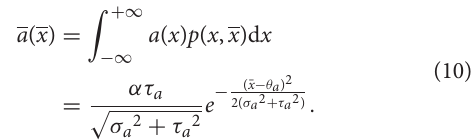
FIGURE 4 | low abundances is taken into account. A shorter handling time ( h prevents trait evolution. When selection is moderately strong ( τ a exceeds the levels that predispose it to extinction, and the mean attack rate evolves to its optimum (